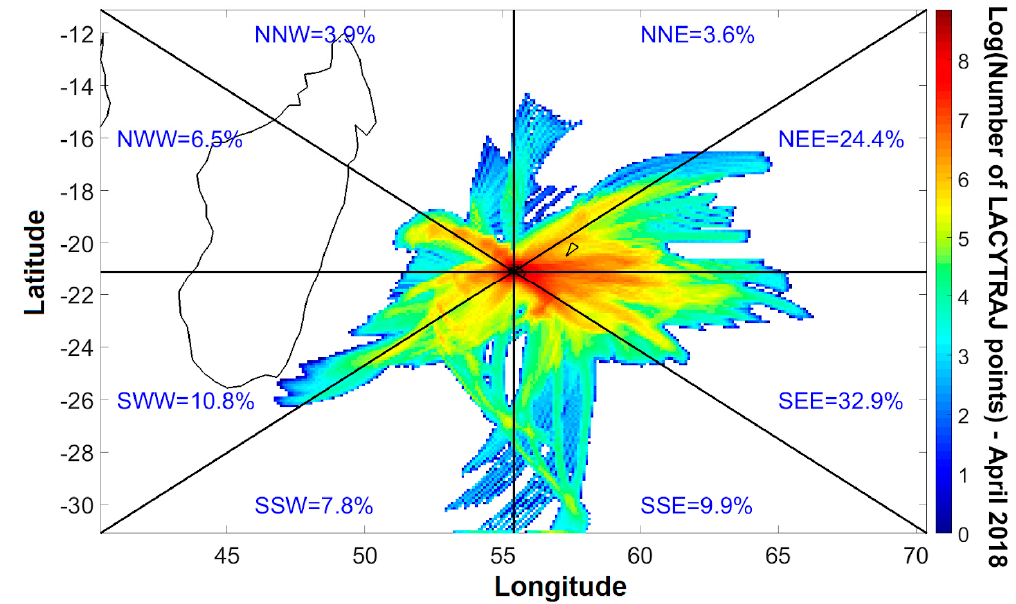
Figure 2. Number of back-trajectories points (color bar) and percentage per direction sectors (in blue) in April 2018.